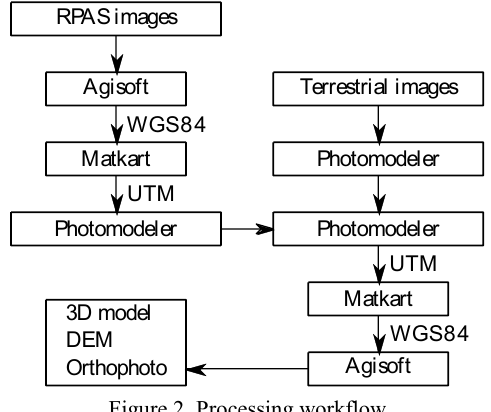
Figure 2. Processing workflow